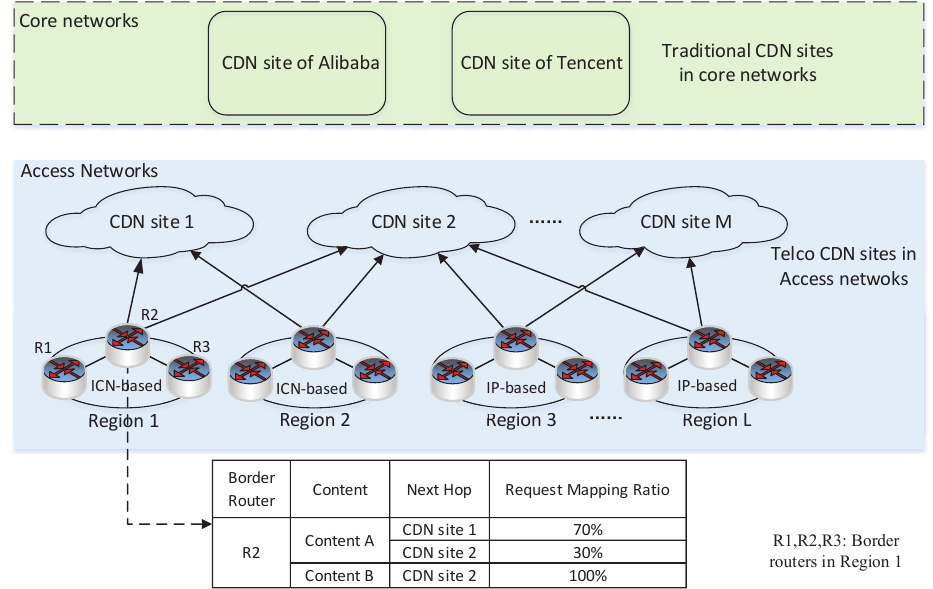
Figure 1. Telco content delivery network (CDN) service scenario in comparison with traditional CDN